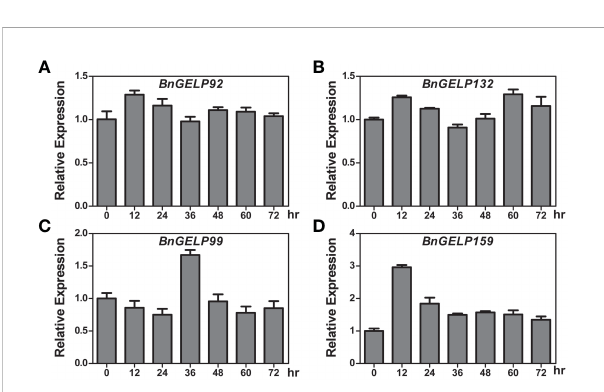
FIGURE 9 Expression of the BnGELP genes identi fi ed by mass spectrometry in response to cold. (A – D) qRT-PCR analysis of the expression of BnGELP92, 132, 99 and 159 in response to cold treatment. Seedlings of B . napus cultivar ZS11 were placed at 4 °C and sampled at 0, 12, 24, 36, 48, 60 and 72 hours. The relative expression levels of BnGELP92, 132, 99 and 159 were normalized to the expression of BnACTIN . The primers are list in Supplementary Table